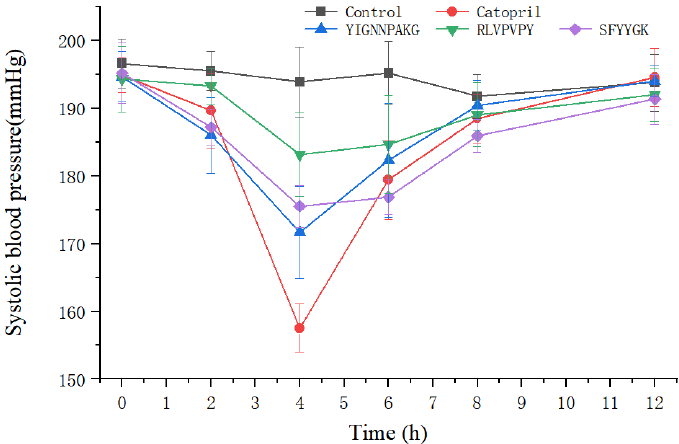
Figure 6. SBP changes in SHRs after the intravenous administration of SFYYGK, RLVPVPY and YIGNNPAKG.